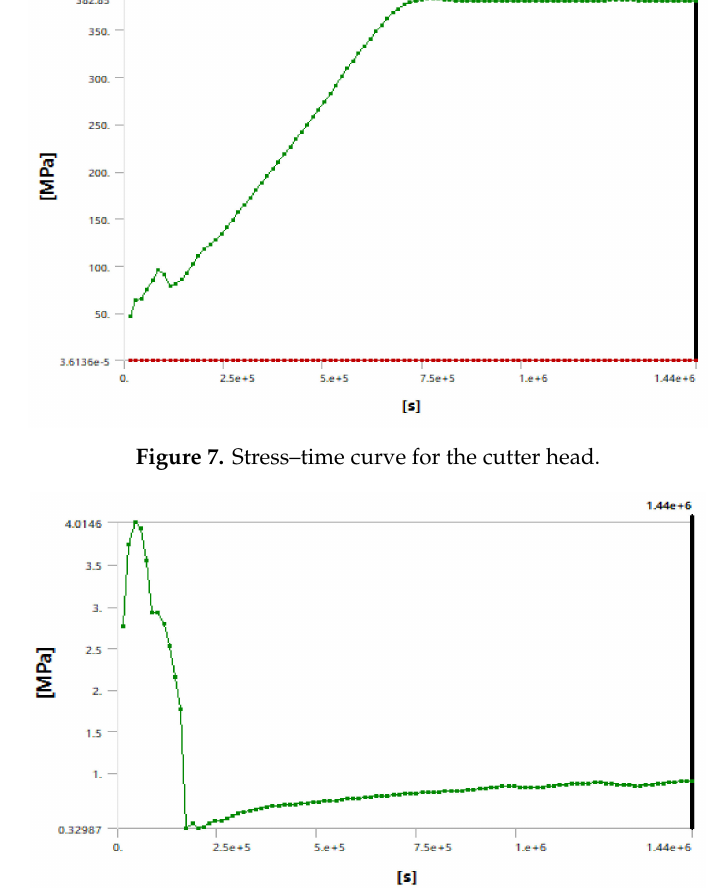
Figure 8. Stress–time curve for the surface between the soft rock layer and the cutter